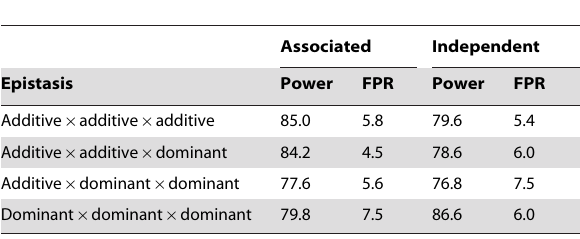
Table 12. Power and false positive rates (FPR) for the detection of three-locus epistasis among associated and independent SNPs for 400 cases and 400 controls.